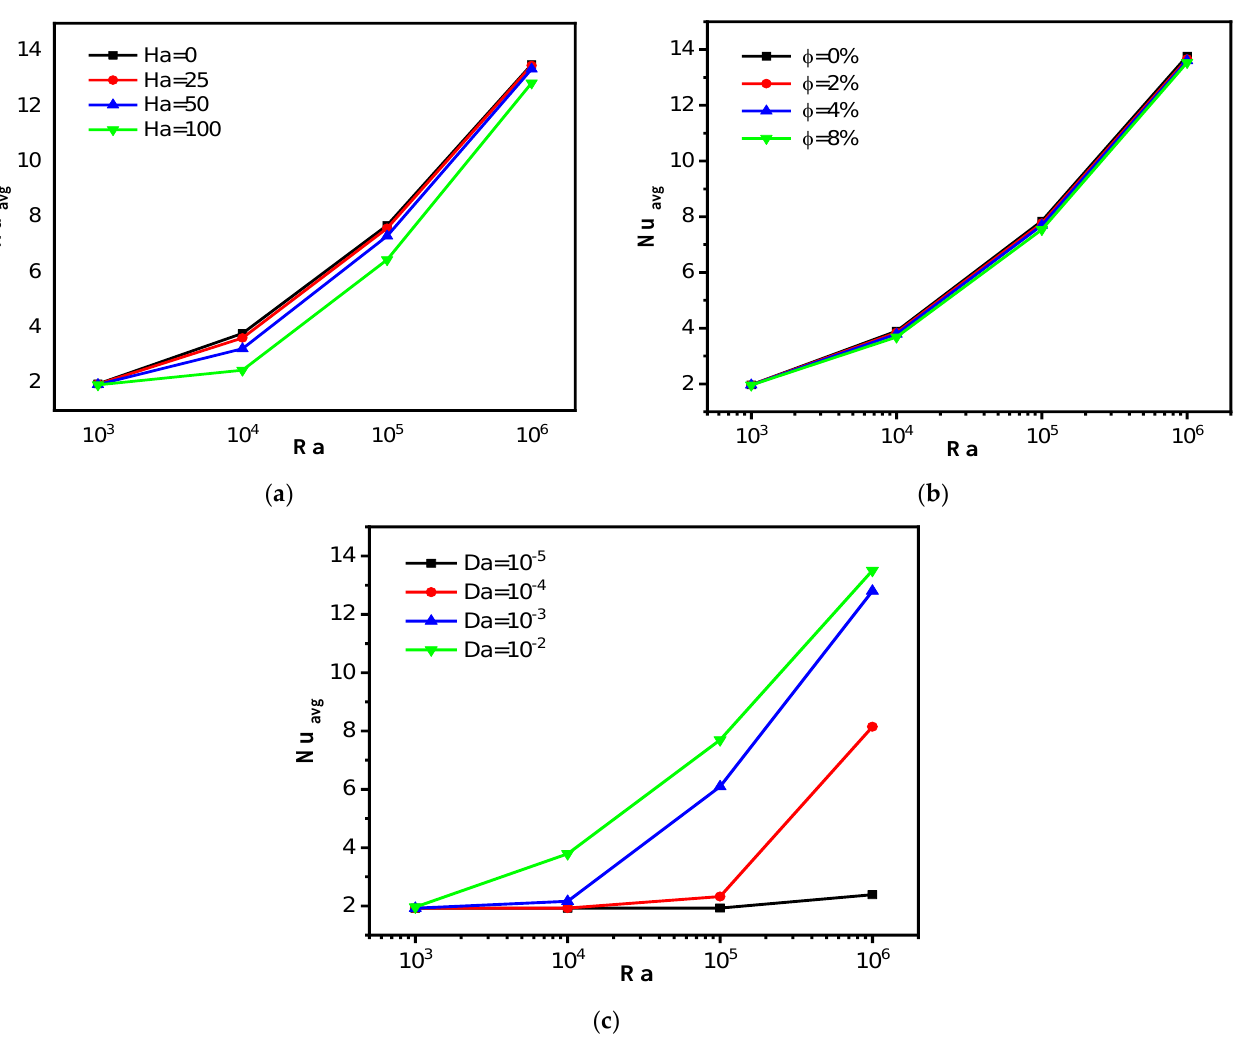
Figure 6. The effect of ( a ) Ha number, ( b ) nanoparticle volume fraction and ( c ) Da number on the Nu avg for different values of Ra.